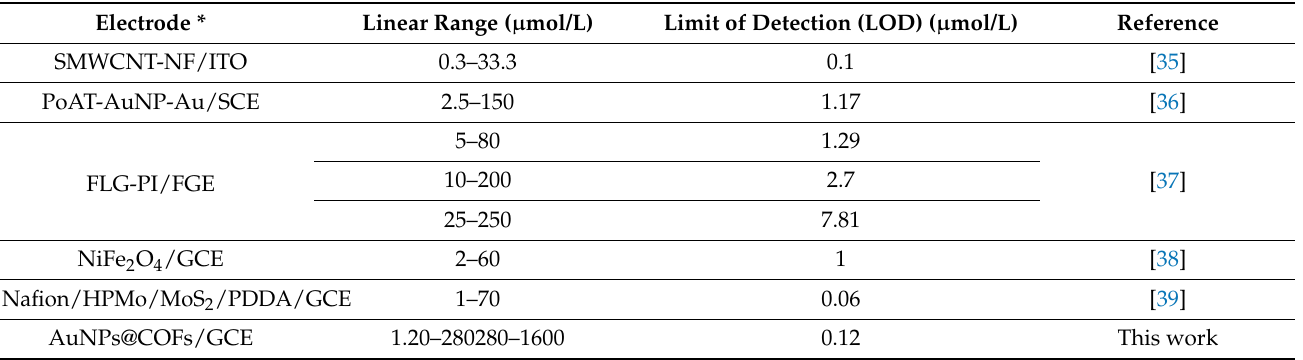
Figure 9. ( A ) The I-T diagram of AuNPs@COFs/GCE for ractopamine was obtained by adding different concentrations of ractopamine into 0.1 mol/L PBS solution at 0.40 V applied voltage. ( B ) Linear fitting curve of ractopamine concentration and current value. Table 1. Performance comparison of different modified electrodes for ractopamine electrocatalytic